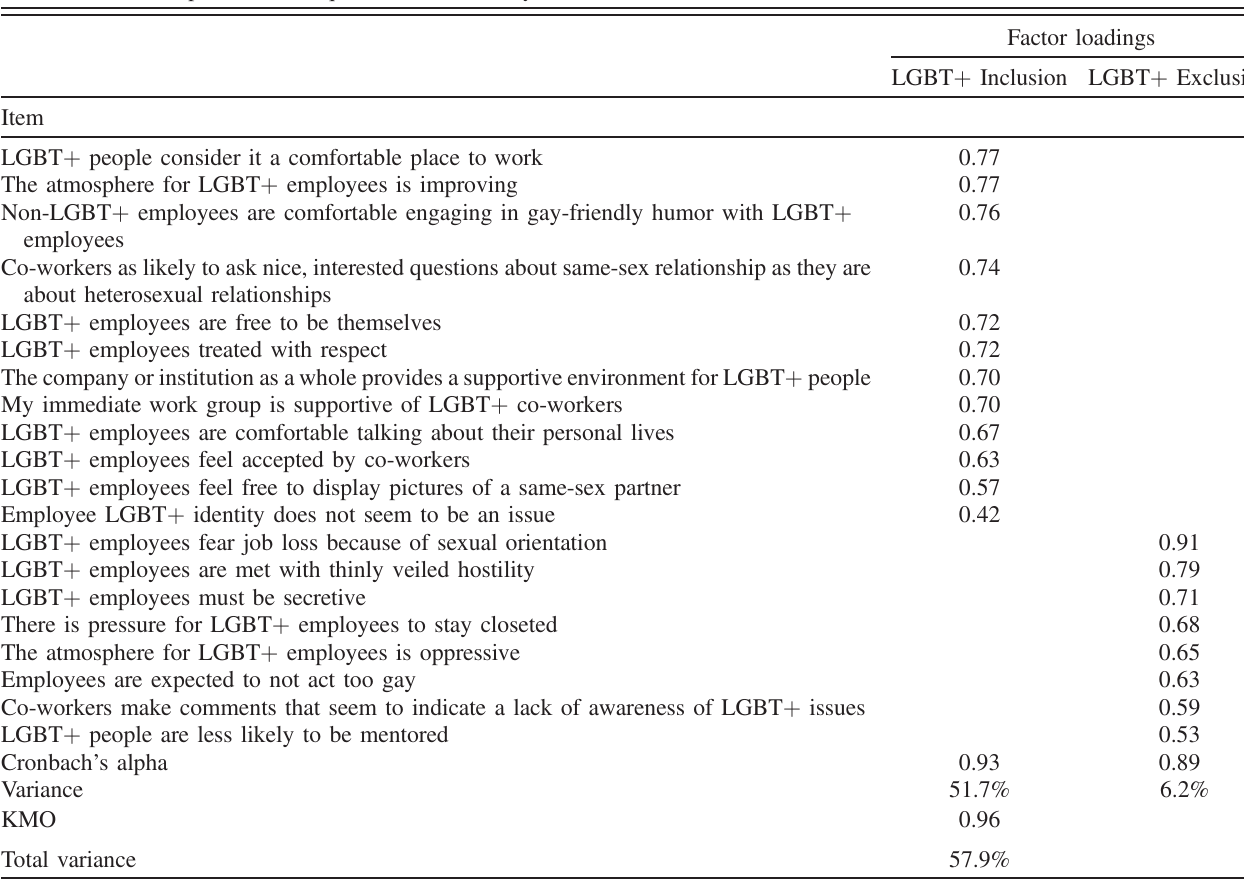
TABLE III. Workplace climate questions factor